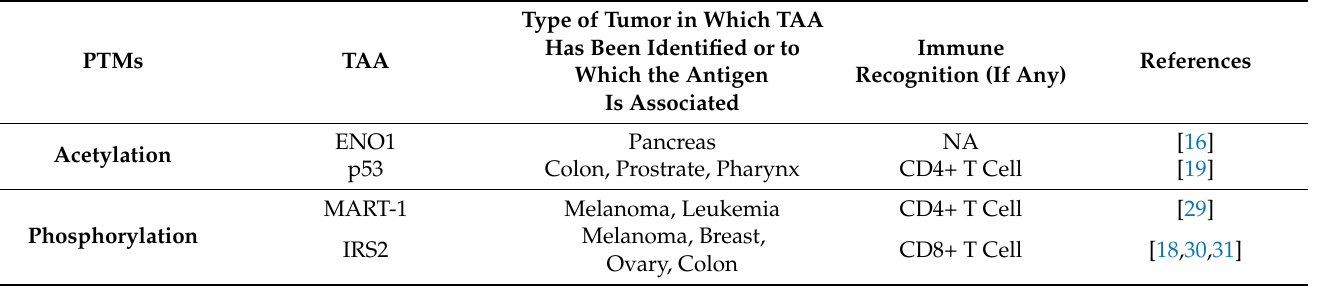
Table 1. Immune response elicited by PTM-modified